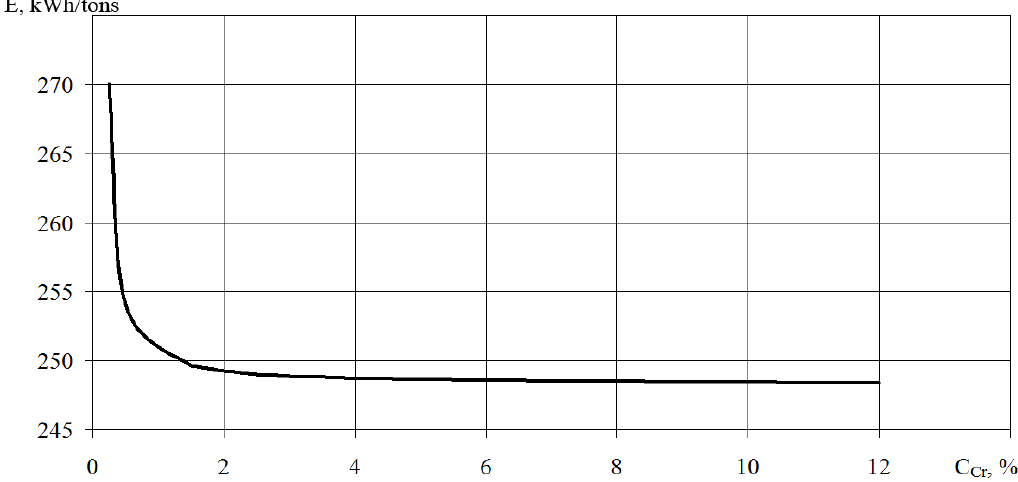
Fig. 4. The influence of increasing of the chromium content in the hardened steel of the auger on energy consumption of the MSW dehydration process after its operation and wear on the path s = 56850